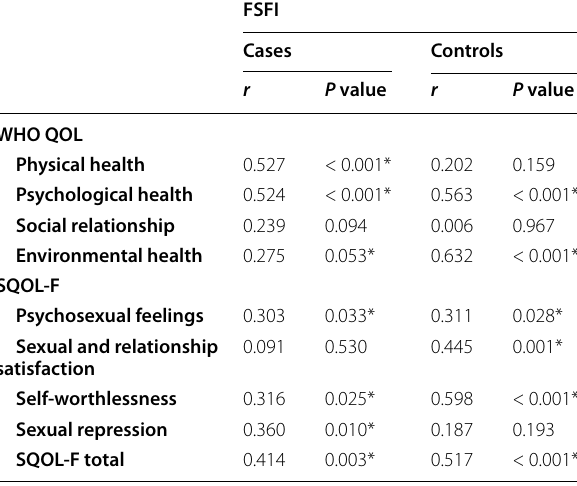
Table 7 FSFI correlation with both WHO QOL and SQOL-F